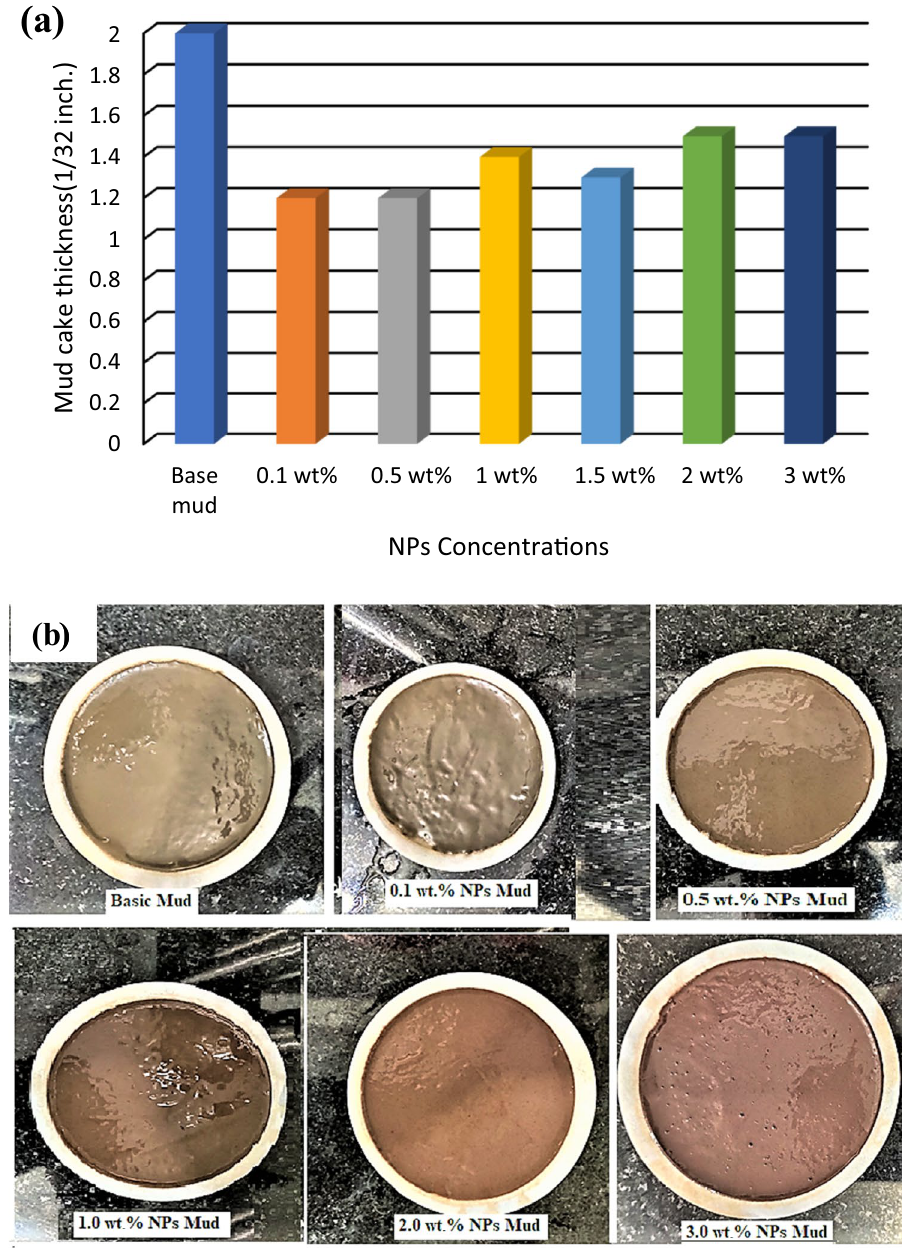
Fig. 11 Under static condition for different NPs concentrations a mud cake thickness and b photo of formed mud